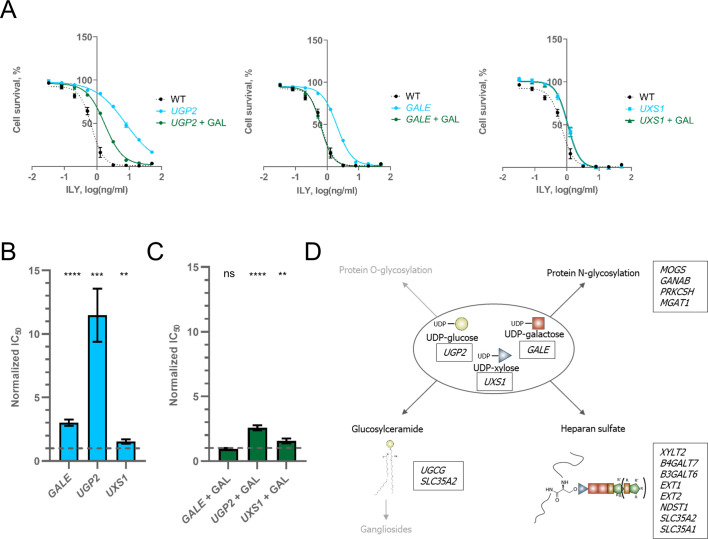
UDP-sugar synthesis gene knock-outs protect against ILY.A. Lysis profiles of cell lines with UDP-sugar gene knock-outs before and after growing them in a galactose enriched medium. n = 3, error bars represent standard deviations. B. Resistance conferred by the knock-out of GALE, UGP2, and UXS1 genes. Values were normalized by dividing the raw IC50 value by the IC50 value of ILY in WT HAP-1 cells. The dashed line shows the WT IC50 value. n = 3, error bars represent standard deviations. p-values were calculated using two-tailed t-test; *–<0.05; **–<0.01, ***–<0.001; ****–<0.0001. C. Resistance conferred by the knock-out of GALE, UGP2, and UXS1 genes when cell media was supplemented with galactose. Values were normalized by dividing the raw IC50 value by the IC50 value of ILY in WT HAP-1 cells. The dashed line shows the WT IC50 value. N = 3, error bars represent standard deviations. p-values were calculated using two-tailed t-test; *–<0.05; **–<0.01, ***–<0.001; ****–<0.0001. D. Schematic representation of glycosylation pathways that use UDP-sugars identified in our screen. Pathway names listed in black represent pathways we studied in depth. Pathway names listed in faded grey represent processes that use UDP-sugars, but no genes from their pathways were identified in our screen. Boxes next to process names enumerate genes in that pathway identified in our screen (proteins produced from listed genes do not necessarily use these UDP-sugars themselves).